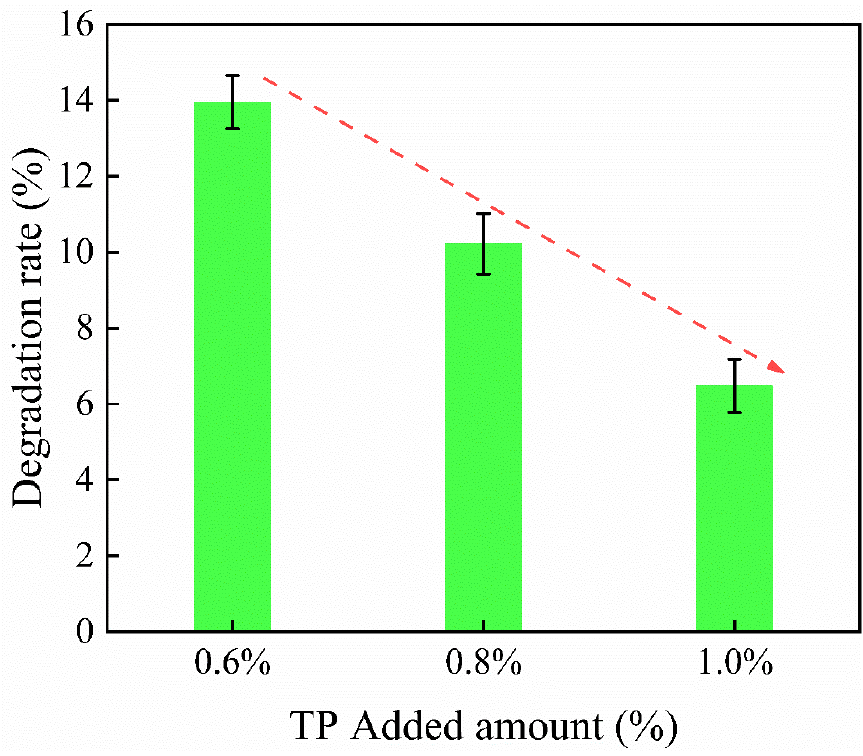
Figure 3. Effect of antioxidant addition on the citral degradation rate.